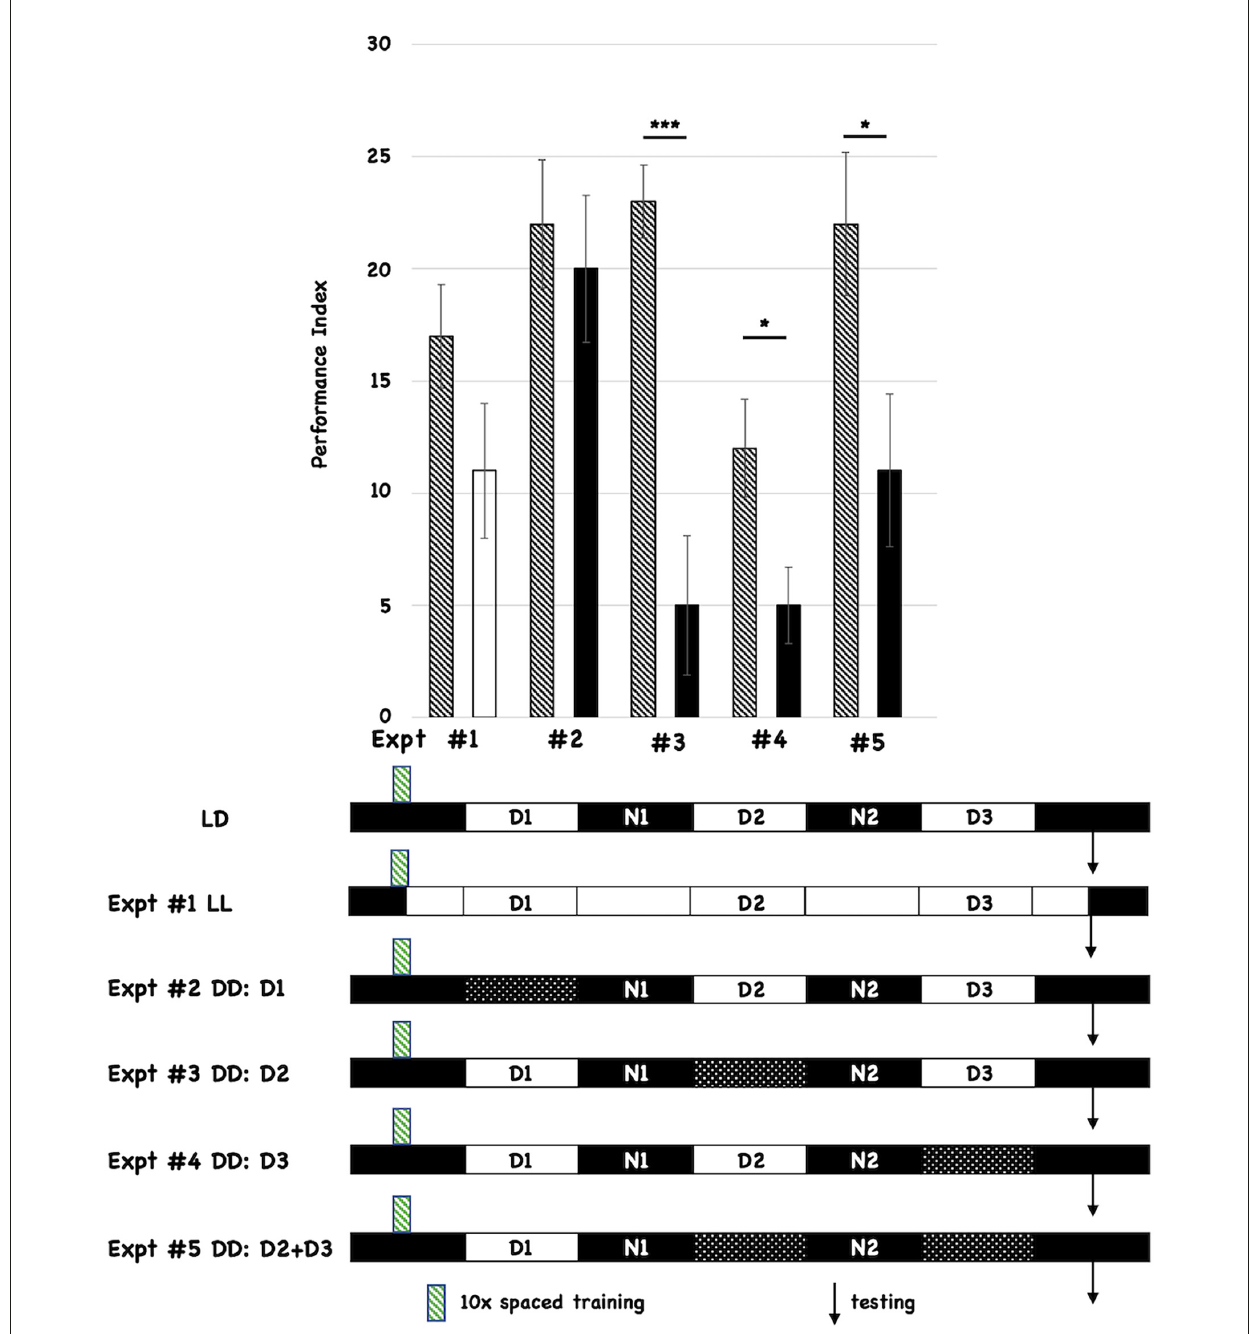
FIGURE1 Post-training incubation of flies in dark:dark (DD) conditions disrupts 3d memory. The behavioral data and summary cartoons of the experimental timeline are presented. At the top of the Figure, the Performance Index is plotted as a function of the post-training incubation schedules, and the different pairwise comparisons are numbered (#1–5). Each experiment compares the performance of flies trained and maintained after training under control (LD) conditions (the control group) vs. an experimental group where the post-training lighting conditions change. “Wild-type” w 1118 flies are used for both control and experimental groups. The performance scores for the control groups are depicted using a histogram with black- and-white stripes. The performance scores of the different experimental groups are represented using a solid white (LL or constant light after training) or solid black histograms (for those that receive the imposition of one or more D periods). N = 8 for all experiments, T -tests were used to evaluate significance. * p < 0.05, *** p < 0.001. All unmarked pairwise comparisons are not significantly different. At the bottom of the Figure, the first horizontal cartoon (labeled LD) describes the standard, control experimental condition. Flies previously entrained to a 12h:12 h light:dark schedule are behaviorally trained with 10 cycles of spaced training during the early nighttime (green striped box). The different post-training periods are shown as white (12 h light) and black (12 h dark) boxes, and they are labeled (Day1 = D1, Night 1 = N1 etc.). Testing (3d after training) is denoted with the black arrow. Each subsequent horizontal timeline shows a different experiment where post-training lighting conditions are altered, and the Experiment number is indicated and corresponds to its behavioral data shown using histograms. Flies exposed to constant light from the end of training to the time of testing are shown with white boxes only. Flies that experience one or more dark periods (when light normally occurs) are shown using double cross-hatched